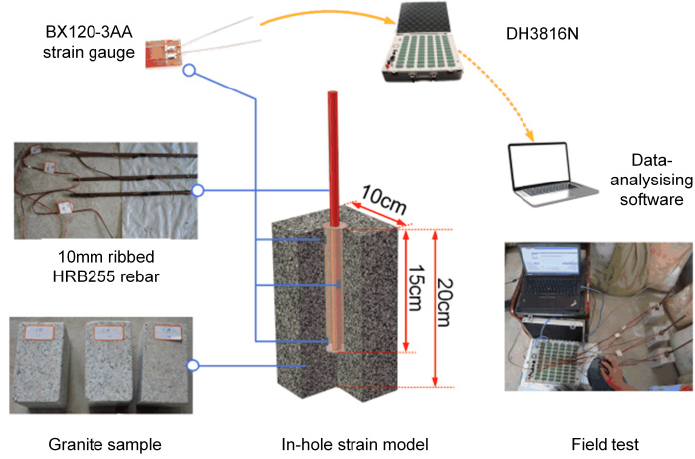
Figure 4. In-hole strain test set-up.